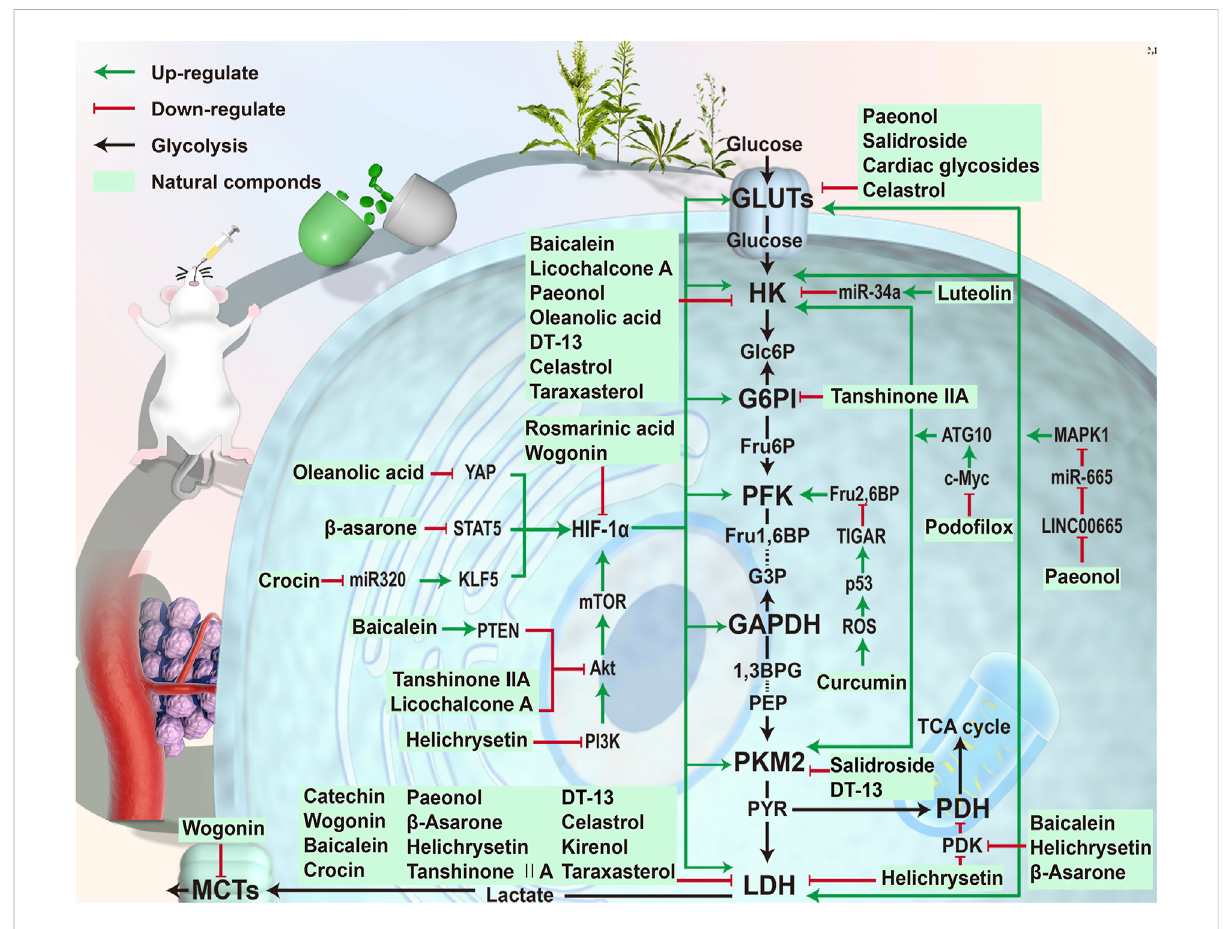
FIGURE 3 Phytochemicals targeting the glycolysis in gastric cancer. Phytochemicals were extracted from plants and tested in vivo or in vitro . These compounds affected the glycolysis process in gastric cancer cells through different ways. Baicalein and other compounds could directly regulate glycolysis-related enzymes. Compounds such as wogonin inhibited glycolysis by suppressing HIF-1 α . Compounds such as curcumin regulated the glycolysis through other